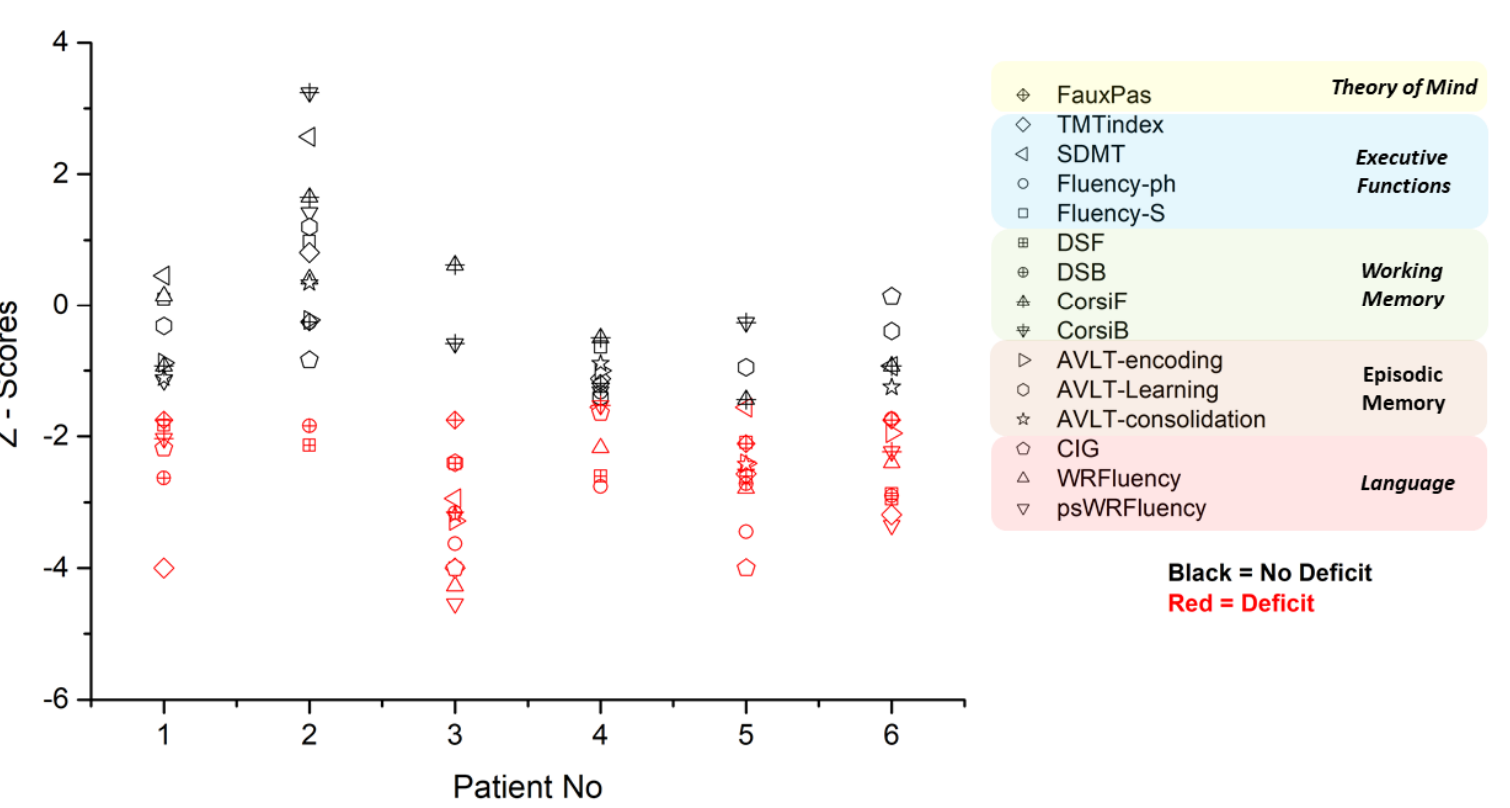
Figure 1. Cognitive performance (in z— scores) of the six patients with full neuropsychological data. Red indicates impaired performance ( z— score at least 1.5 SD below the mean). Fluency — S z: z— scores for the semantic subscale of the Controlled Oral Word Fluency; Fluency — ph z: z— scores for the phonemic subscale of the Controlled Oral Word Fluency; WRFluency z: z— scores for the word reading fluency; psWRFluency z: z— scores for the pseudoword reading fluency; TMTindex z: z— scores for the Derived index of Trail Making Test; SDMT z: z— scores for the Symbol Digit Modality Test: AVLT — encoding z: z— scores for the encoding subscale of the Auditory Verbal Learning Test; AVLT — Learning z: z— scores for the learning subscale of the Auditory Verbal Learning Test; AVLT — consolidation z: z— scores for the consolidation subscale of the Auditory Verbal Learning Test; CIG z: z— scores for the Comprehension of Instructions in Greek; DSF z: z— scores for the Digit Span task Forward; DSB z: z— scores for the Digit Span task Backward; CorsiF z: z— scores for the Corsi Block — Tapping task Forward; CorsiB z: z— scores for the Corsi Block — Tapping task Backward; FauxPas z; z— scores for the Faux Pas Recognition Test. PPVT — R and BNT are not shown here, since for these tests only percentiles were available. However, impaired vs. non — impaired performance for these two tests is visualized in (Figure 2) (on the basis of a 5th percentile